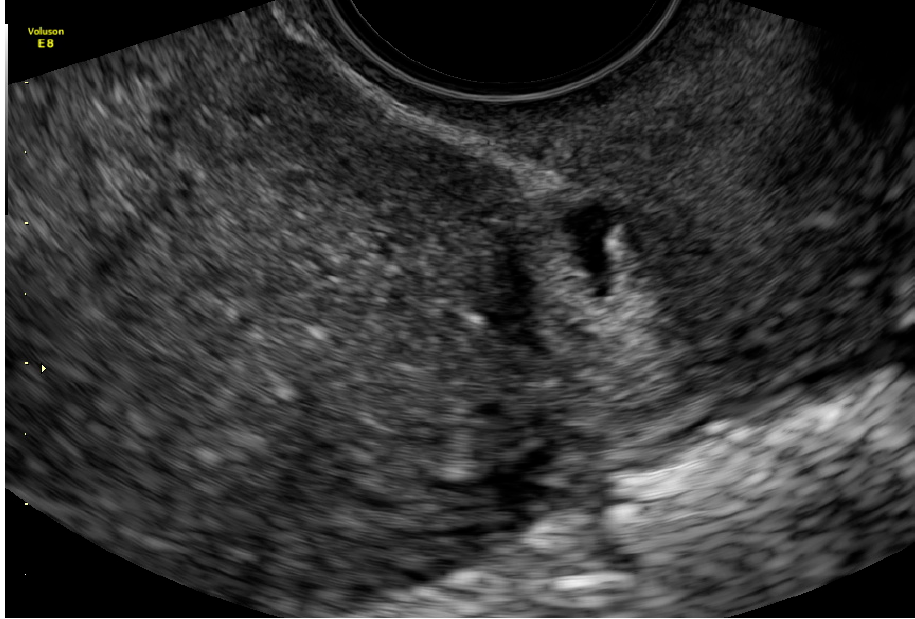
Figure 7. The sagittal section of uterus by vaginal probe with visible “niche” of cesarean scar area in size 3 × 7 mm.